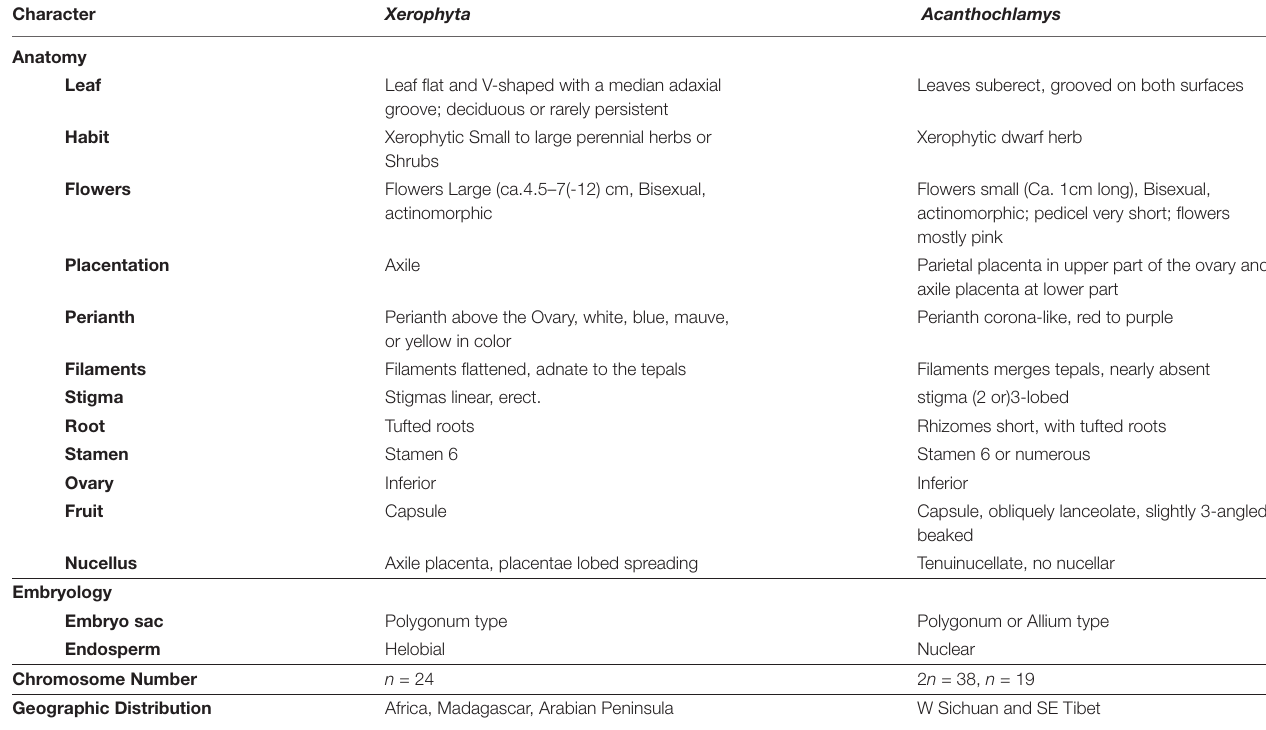
TABLE 4 | Comparison of morphological characters between Xerophyta and Acanthochlamys